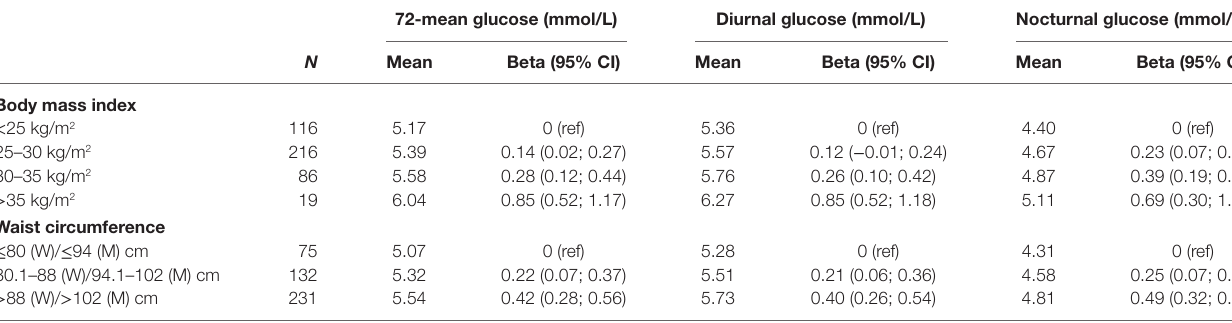
TaBle 2 | Associations of measures of adiposity and indices of glycemia in the meta-analyses. 72-mean glucose (mmol/l) Diurnal glucose (mmol/l) nocturnal glucose (mmol/l) N Mean Beta (95% ci) Mean Beta (95% ci) Mean Beta (95%